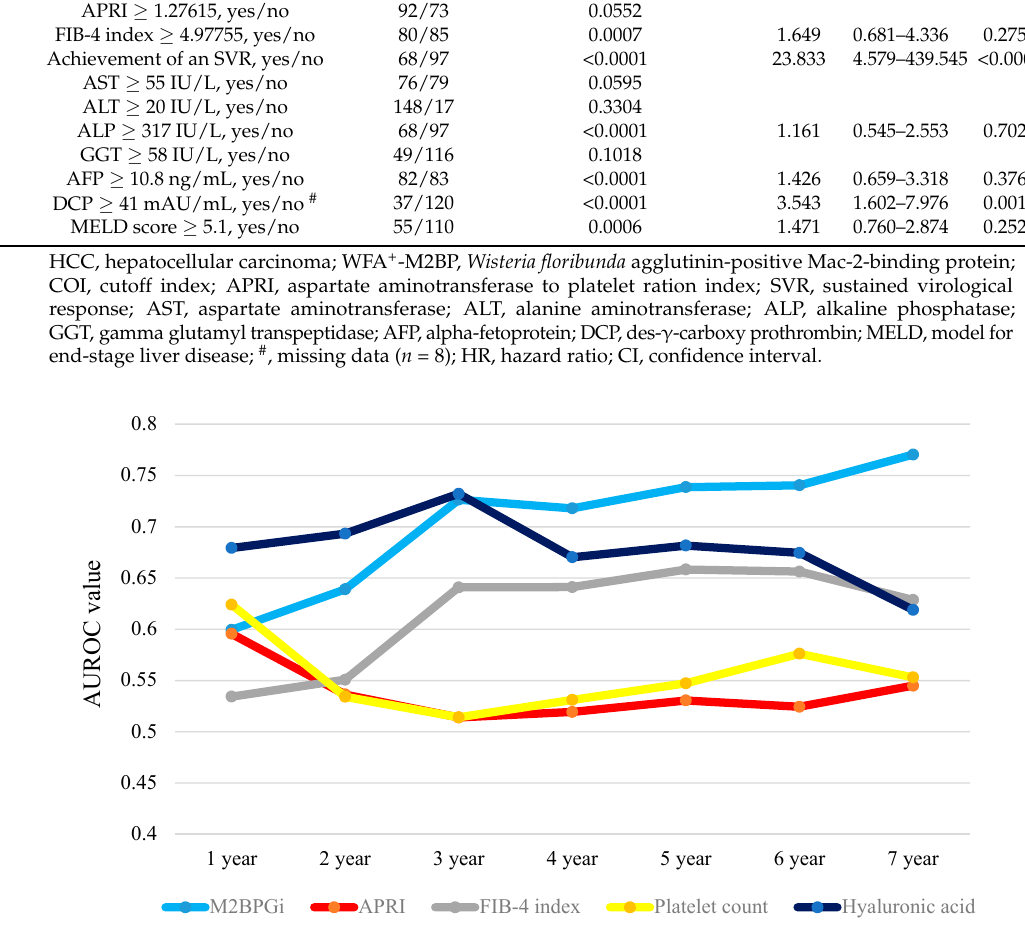
Figure 5. Time-dependent ROC analyses of five liver fibrosis markers (WFA + -M2BP, aspartate aminotransferase to platelet ration index (APRI), Fibrosis-4 (FIB-4) index, platelet count and hyaluronic acid) for overall survival (OS) in all cases. This figure presents the plots of annual AUROCs of five liver fibrosis markers. The total sum of AUROCs in all time-points (TAAT) score indicates total sum of AUROCs in all time-points in each liver fibrosis marker. TAAT score: WFA + -M2BP: 4.93226; APRI: 3.76484; FIB-4 index: 4.31010; platelet count: 3.87966 and hyaluronic acid: